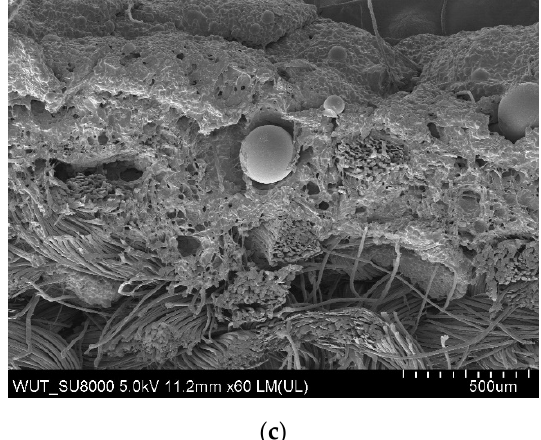
Figure 7. ( a ) SEM image of coating incorporating glass particles with a size of 315–500 µm (additive 10). ( b ) SEM image of coating incorporating glass particles with a size of 250–350 µm (additive 11). ( c ) SEM image of coating incorporating glass beads with a diameter of 125–630 µm (additive 12).